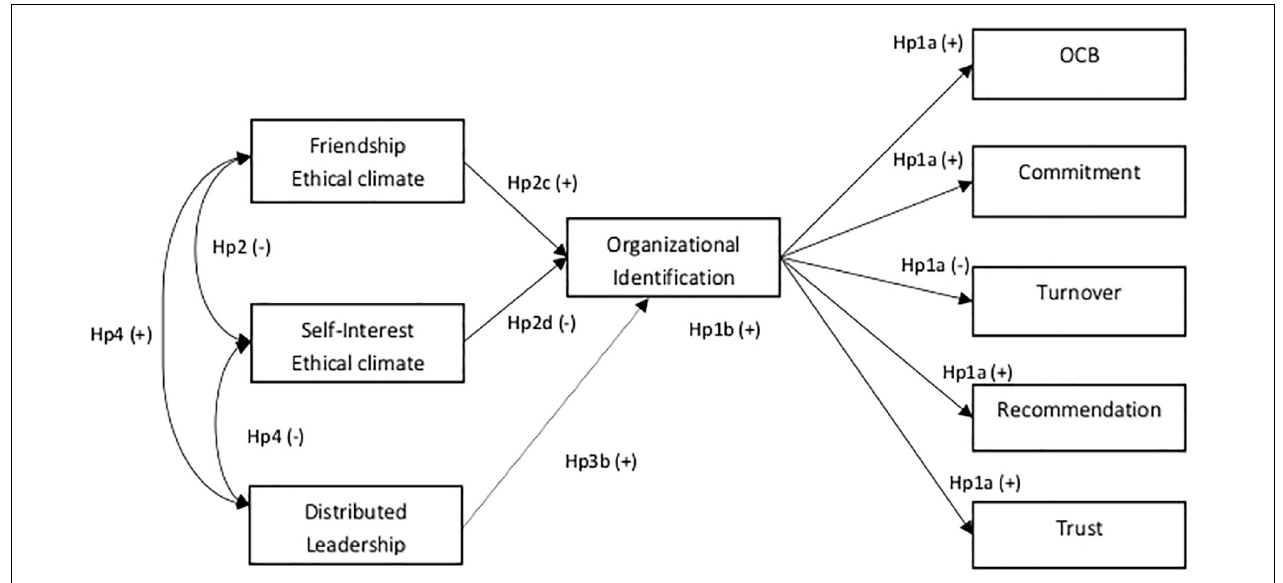
FIGURE 1 | Research model and